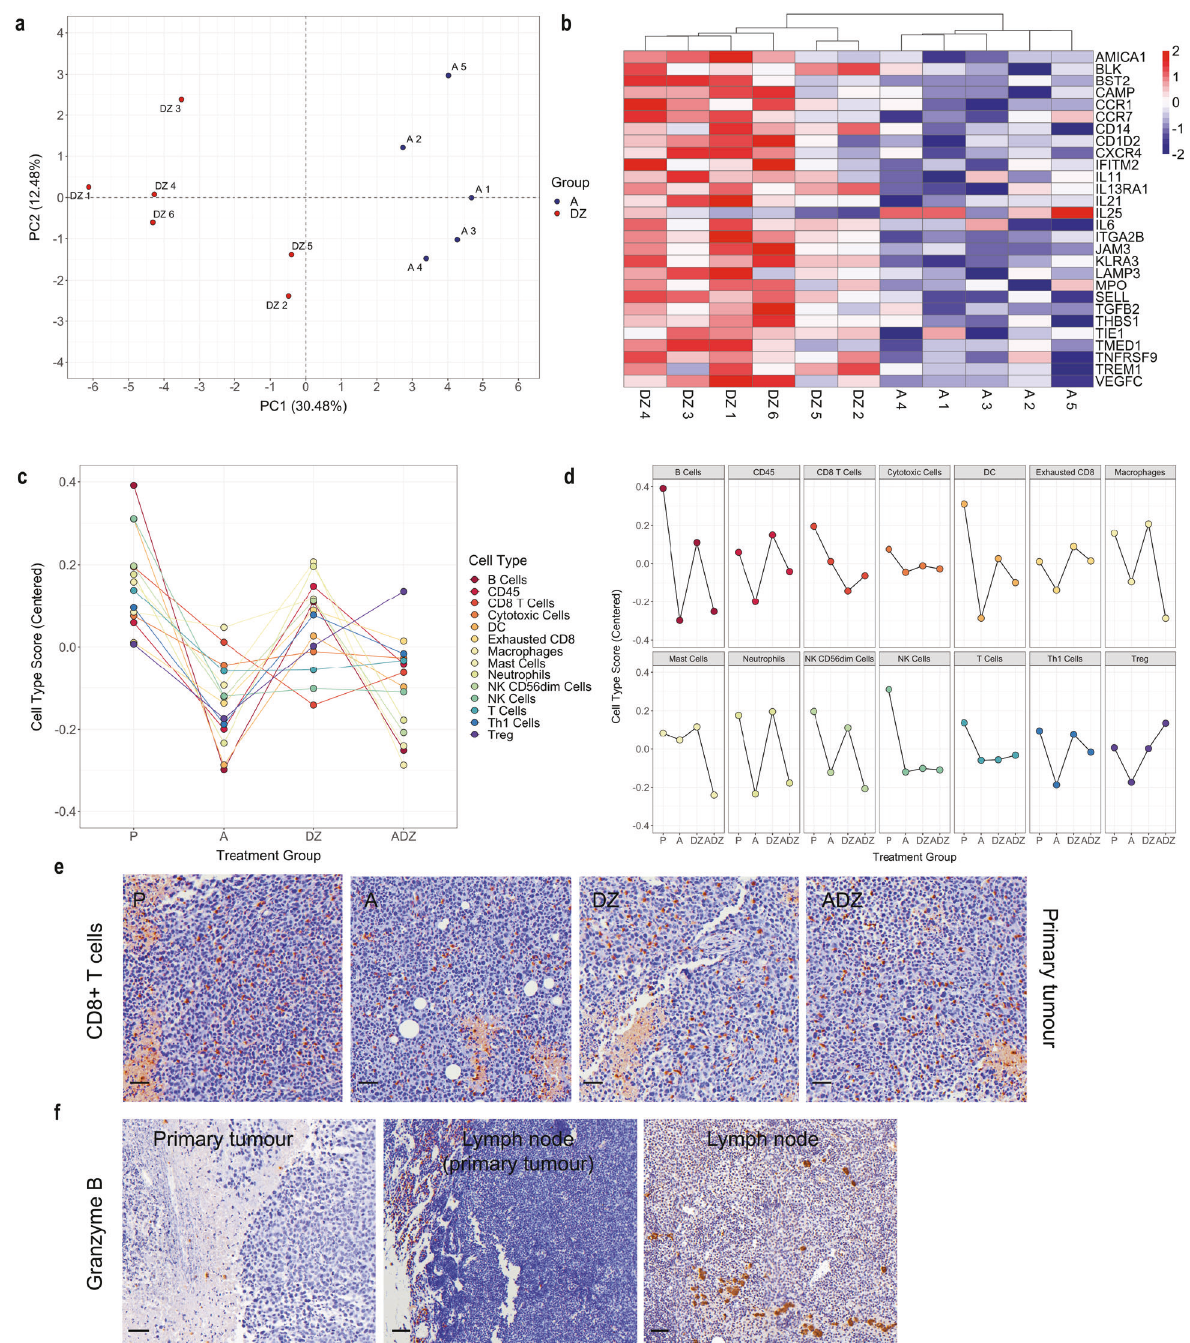
Fig. 7 Combining Anakinra, Doxorubicin, and Zoledronic acid affects tumour-associated immune signatures in a syngeneic model of spontaneous breast cancer metastasis to bone. a PCA plot. Each dot corresponds to a primary tumour from each treatment group (A or